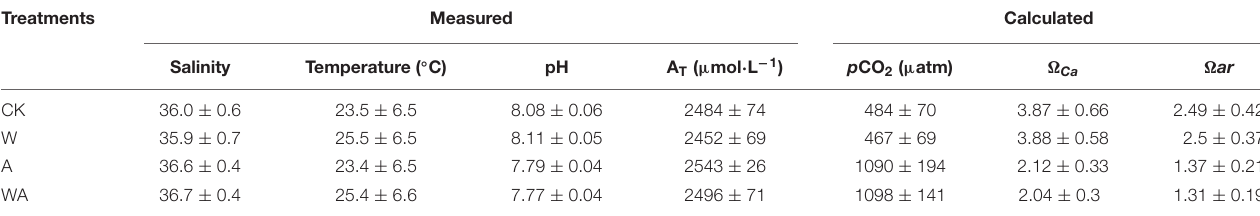
TABLE 1 | Seawater carbonate chemistry in the seawater acidification and warming system during the experiment. Treatments Measured Calculated Salinity Temperature ( ◦ C)